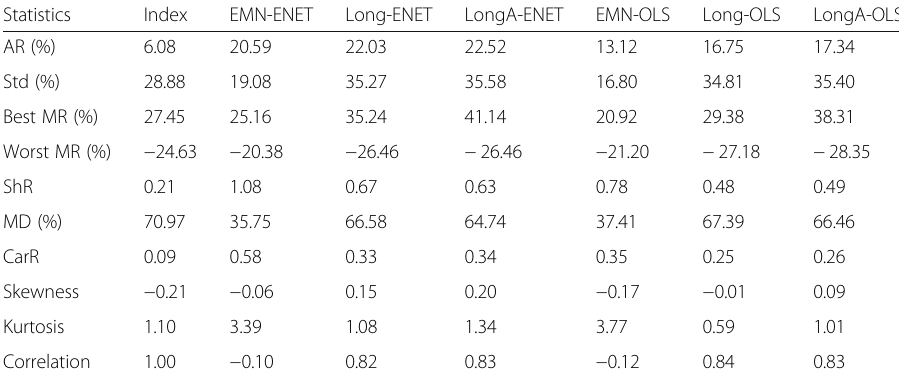
Table 2 Performance measures during 2003 – 2015